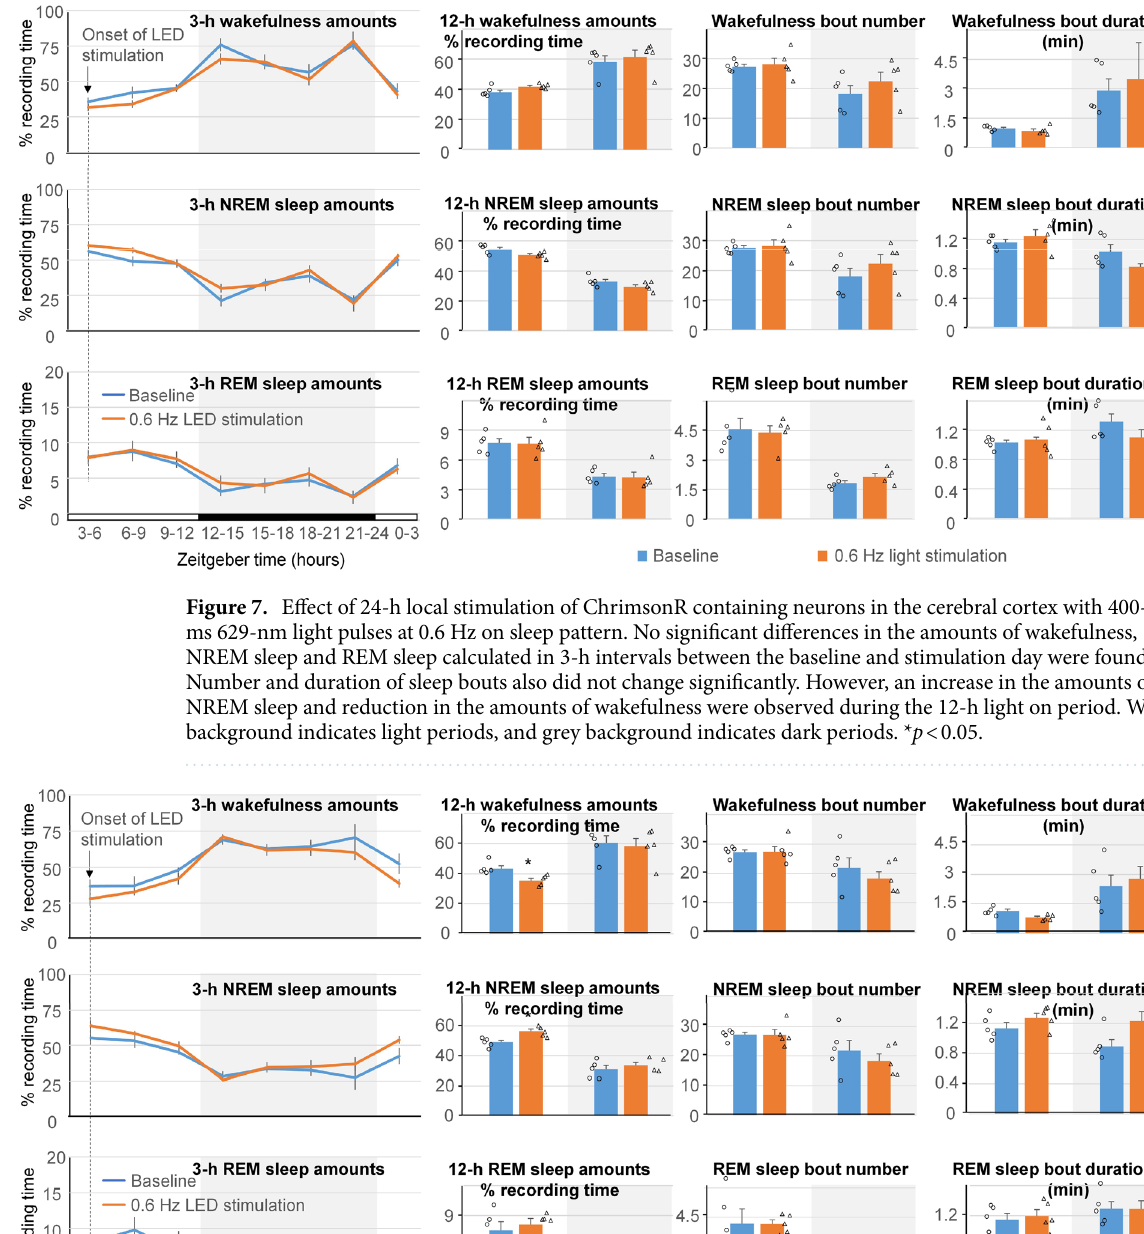
(Supplementary Fig. 6, blue line). Thus, optogenetic stimulation was effective at increasing the power of slow oscillations, while potentiating NREM sleep in mice. Effect of local activation of GABAergic neurons in the cerebral cortex on expression of cFos. To demonstrate that activation of GABAergic neurons in the cerebral cortex can be achieved using LEDs placed on the top of the skull, we injected C57BL/6 J mice with AAVs expressing either ChrimsonR-RFP